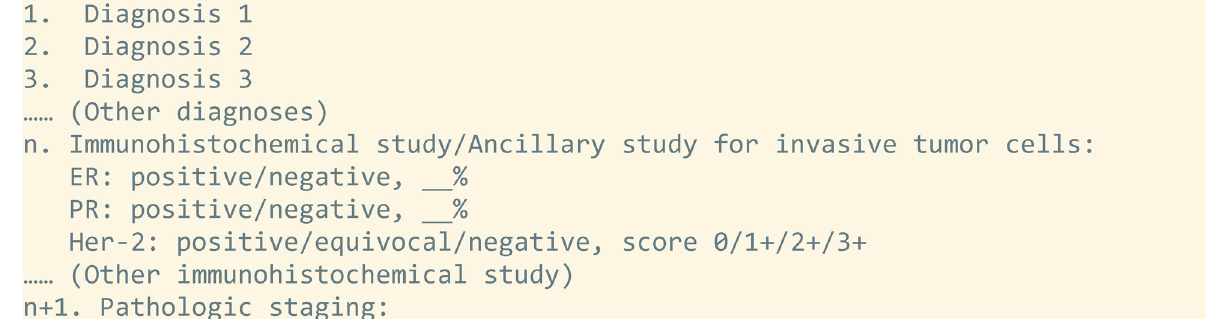
Figure 4: Reporting immunohistochemical study result as a solitary paragraph with multiple rows.